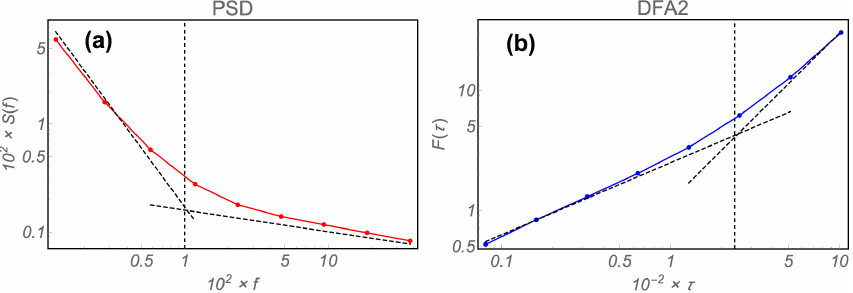
Figure 4. (a) The power spectral density of an ensemble mean of synthetic processes comprised of a superposition of a white noise ( β = 0.2) and a Brownian motion ( β = 1.8). (b) DFA fluctuation function F 2 ( τ ) for ensemble mean of the same process. The dashed lines are the limiting slopes at short/long scales. Their intersection is used to define a transition frequency (vertical dashed line) between the two scaling regimes in (a) and a transition scale for the DFA in (b)